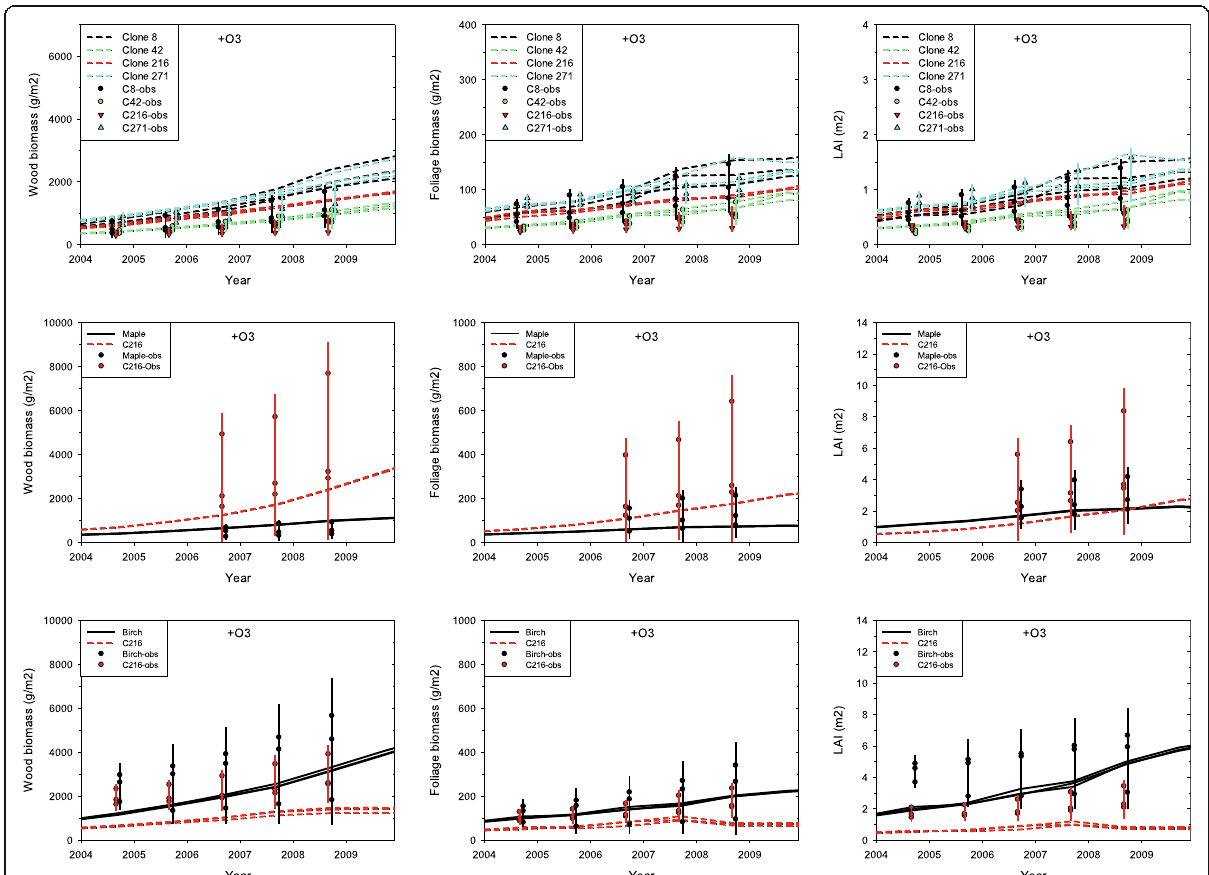
Fig. 3 Comparison of modeled values (dashed lines show each replicate) with empirical observations (symbols) of mid-summer values under elevated ozone (+O3) conditions. Symbols and 95% confidence intervals (vertical solid lines) are offset to enhance visual clarity ( N =